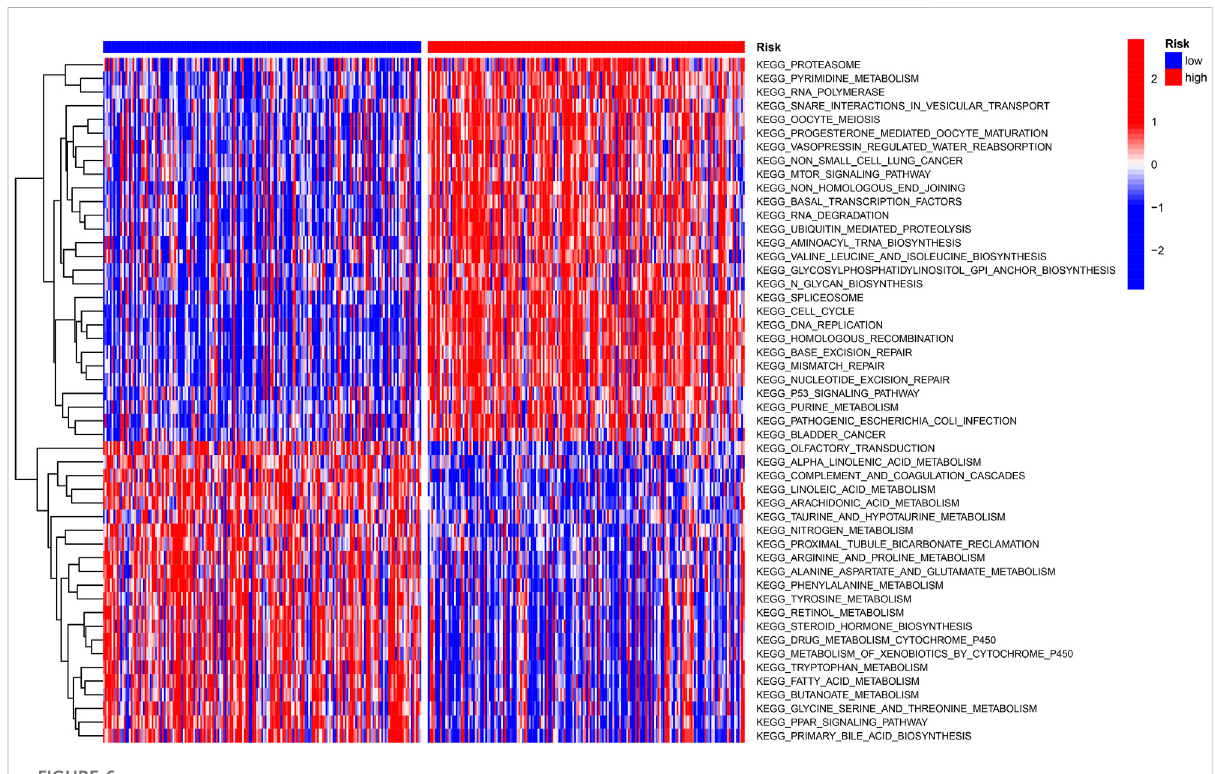
FIGURE 6 Heatmap of GSVA enrichment between low-risk and high-risk score